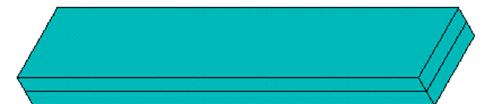
Figure 9. Finite element model of the piezoelectric ceramic bilaminated vibrator.